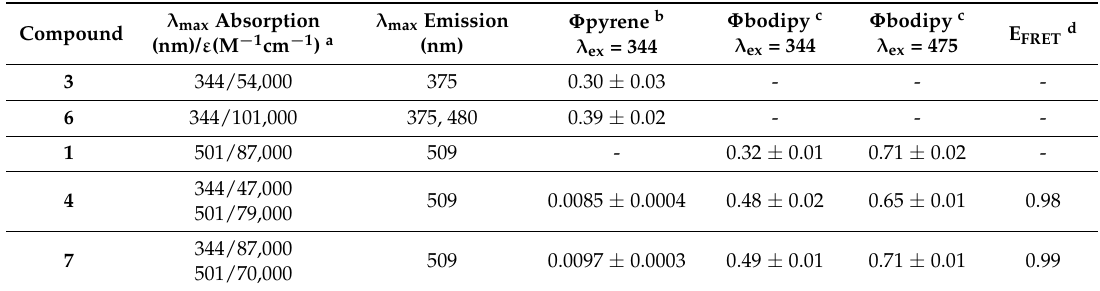
Table 1. Absorption coefficients, quantum yields, and fluorescence resonance energy transfer (FRET) efficiencies for the pyrene-labelled aldehyde precursors 3 and 6 and the pyrene-labeled bodipy compounds 1 , 4 , and 7 .